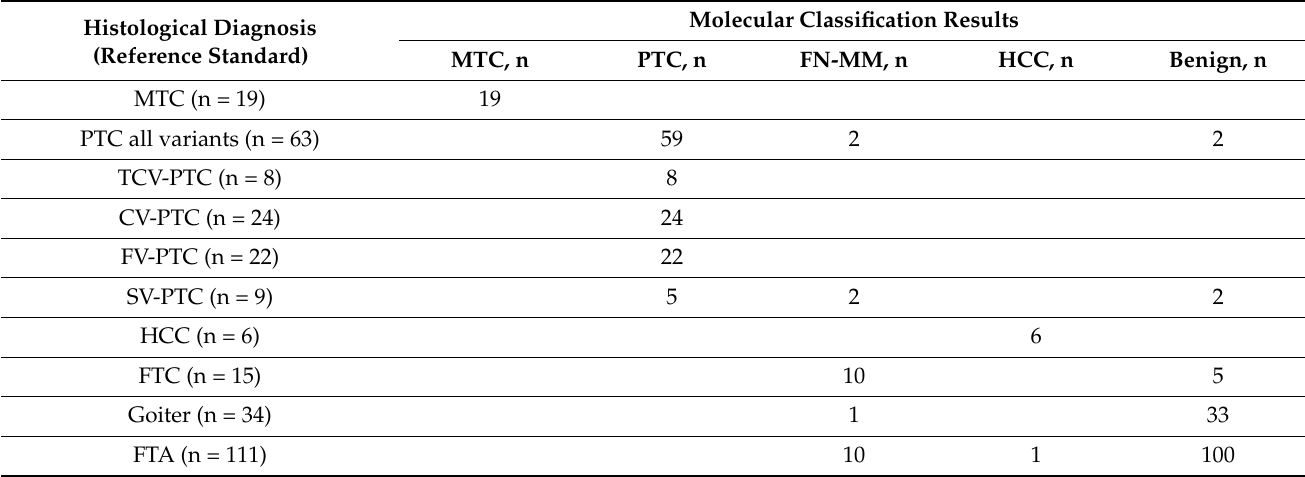
Table 1. Molecular versus histological classification of thyroid nodules.